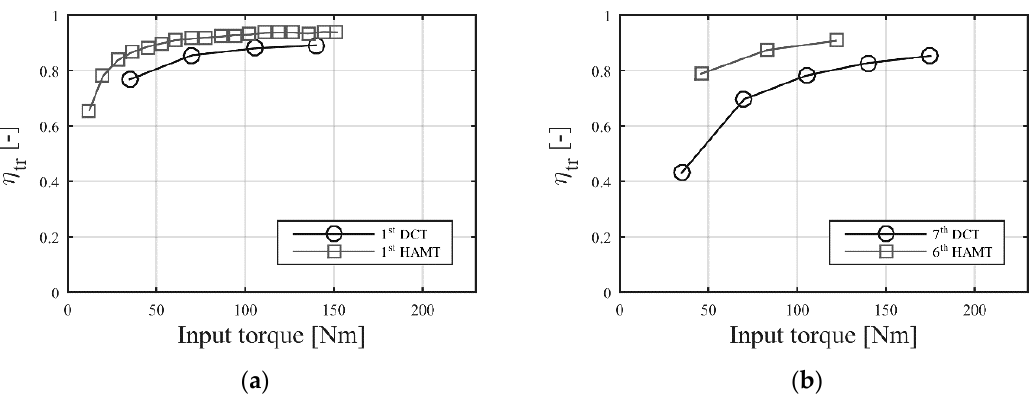
Figure 10. Comparison of the experimentally measured efficiencies of the case study DCT and HAMT at ω in = 2000 rpm and θ tr = 70 ◦ C: (a) first gear; (b) seventh gear (DCT) and sixth gear (HAMT).